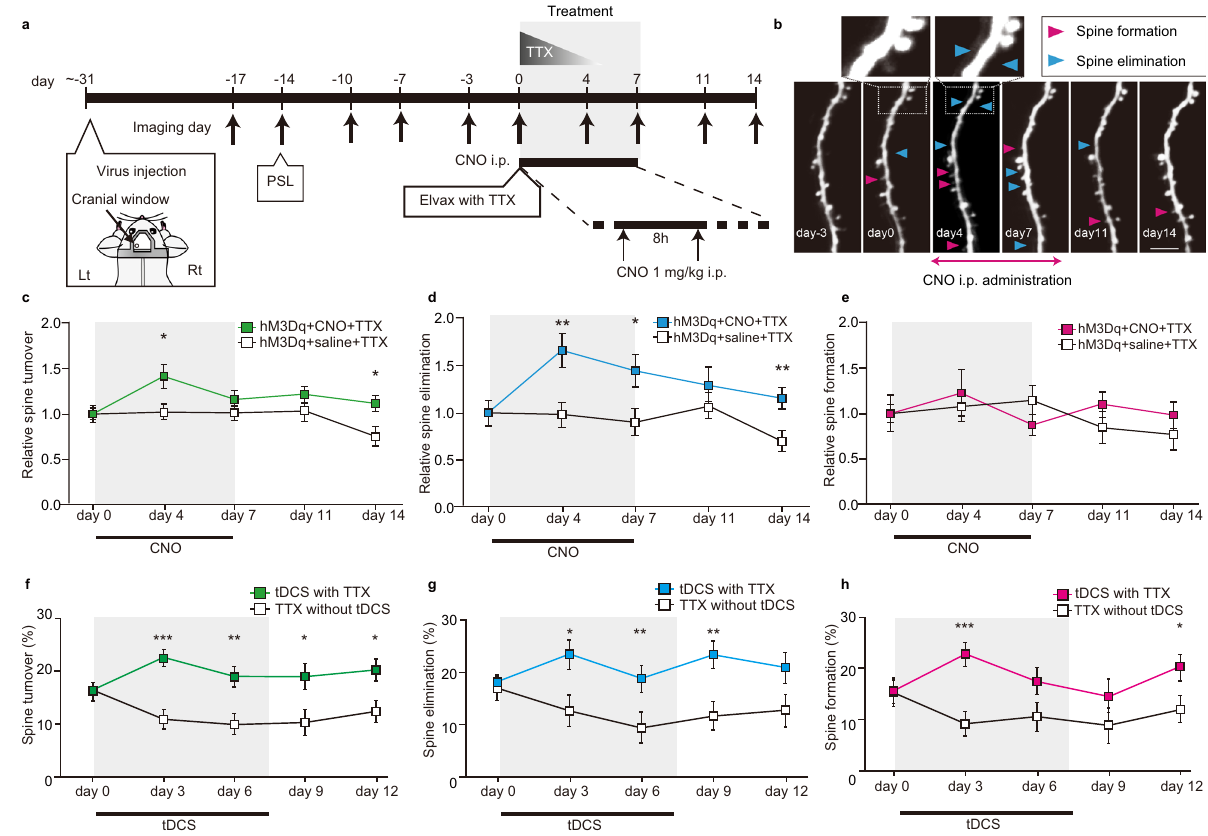
Fig. 3 Increased dendritic spine elimination accompanies the reversal of mechanical allodynia-like behaviour by CNO-TTX or tDCS-TTX therapy. a Schematic of the experimental schedule. The start of CNO-TTX (or control) treatment was designated as “ day 0 ” . In vivo 2-photon imaging of spine dynamics was performed (arrows) before injury (day 17 – day 14), and before (day 10 – day 0), during (day 1 – day 7) and after (day 8 onwards) CNO-TTX treatment. Surgery for head-plate fi xation, gfaABC1D-hM3Dq-mCherry AAV injection and PSL, and measurement of mechanical paw withdrawal thresholds (arrows), and TTX administration (graded triangle) were performed as in Fig. 2. b Repeated imaging of the same dendritic segment from a layer 5 pyramidal neuron in the left (PSL-contralateral) S1 before (day 3 – day 0), during (day 4 – day 7) and after (day 11 – day 14) CNO-TTX treatment. Arrowheads indicate spine formation (magenta) and spine elimination (blue). Scale bar = 5 μ m. Insets show magni fi ed regions as indicated by dashed boxes. The experiments showed successful reproducibility. c – h Graphs plotting measures of spine dynamics as mean ± SEM at various time-points before (day 0), during (day 1 – day 7) and after (day 8 onwards) the treatment period (grey shading). For all graphs separately, statistical signi fi cance was tested using a two-way repeated measures ANOVA, followed by Bonferroni post hoc tests comparing treatment cohorts at each time-point, * p < 0.05, ** p < 0.01, *** p < 0.001. Source data are provided as a Source Data fi le. c – e The treatment period refers to CNO-TTX ( n = 19 dendrites from 5 mice) or control saline- TTX ( n = 16 dendrites from 7 mice) therapy administered as in Fig. 2. Spine dynamics are reported as values normalized to day 0 (see Supplementary Fig. 14 for absolute values and explanatory note). c Spine turnover, CNO-TTX (green), control saline-TTX (white). d Spine elimination, CNO-TTX (blue), control saline-TTX (white). e Spine formation, CNO-TTX (magenta), control saline-TTX (white). f – h The treatment period refers to tDCS-TTX ( n = 16 dendrites from 3 mice) or control TTX-alone ( n = 14 dendrites from 5 mice) therapy administered as in Fig. 1. Spine dynamics are reported as absolute values. f Spine turnover, tDCS-TTX (green), control TTX-alone (white). g Spine elimination, tDCS-TTX (blue), control TTX-alone (white). h Spine formation, tDCS-TTX (magenta), control TTX-alone (white). TTX therapy. The frequency of Ca 2 + transients was signi fi cantly sciatic nerve. Lidocaine was delivered during the 1st three days of (albeit modestly) decreased, and most mice showed a decrease in the tDCS therapy and then the pump was surgically removed averaged S1 neuronal activity (Supplementary Fig. 16). This suggests (Fig. 5a). Control mice had the same lidocaine delivery but no that loss of the maladaptive circuits formed after PSL may reduce the tDCS. While the effects of lidocaine on paw withdrawal thresh- enhanced excitability of S1 subsequent to nerve injury. We propose olds were weaker than TTX, combined transient lidocaine with that this preferential loss of early post-PSL spines represents a tar- tDCS therapy still caused a sustained and signi fi cant reduction in geted pruning of the aberrant neural connections that critically the extent of allodynia-like behaviour that outlasted the treat- contribute to the chronic tactile and thermal allodynia-like behaviour. ment period (Fig. 5b, mean ± SEM of paw withdrawal thresholds (g); lidocaine with tDCS mice (blue, n = 7) were: Spontan.: Preclinical evaluation of combined tDCS and lidocaine ther- apy . While TTX effectively blocked noxious afferent inputs during the therapeutic window, it is too toxic to be integrated into clinical application. Therefore, we evaluated the use of a local anaesthetic, applying lidocaine via a subcutaneous osmotic pump (2 mg/kg/h) with its output aimed close to the injured NATURE COMMUNICATIONS| (2022) 13:4100